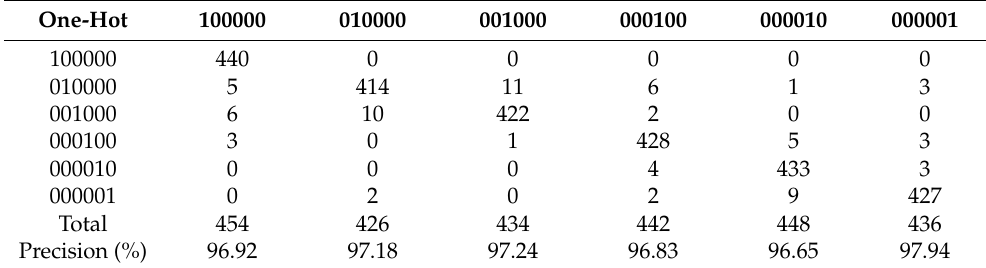
Table 7. Confusion matrix of the test samples for the TICAENet model.